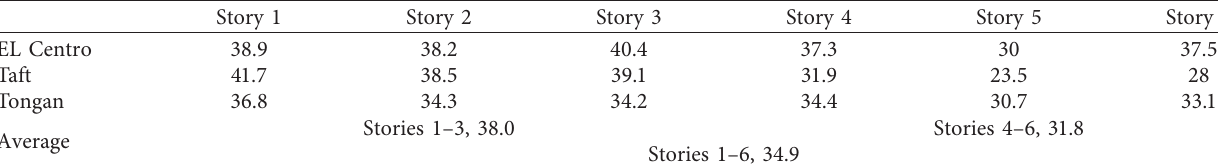
Table 2: Story shear seismic reduction ratio (%).